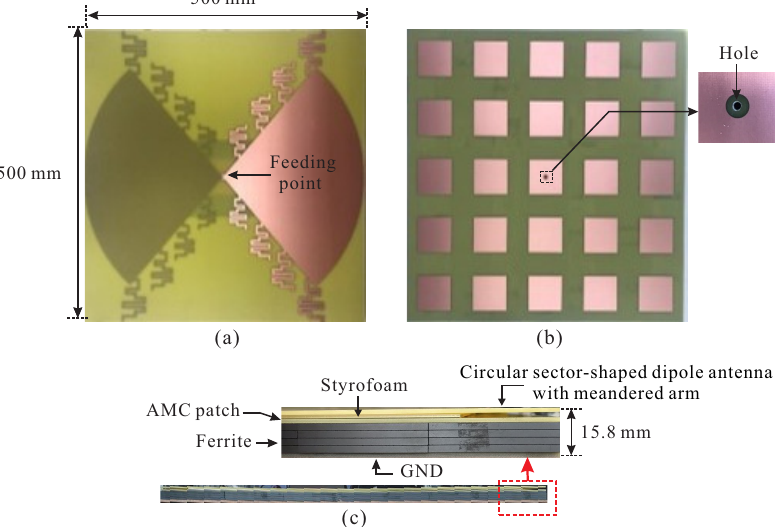
Figure 7. Photographs of a fabricated circular sector-shaped dipole antenna with an AMC structure: ( a ) circular sector-shaped dipole antenna; ( b ) 5 × 5 AMC structure; ( c ) side view.